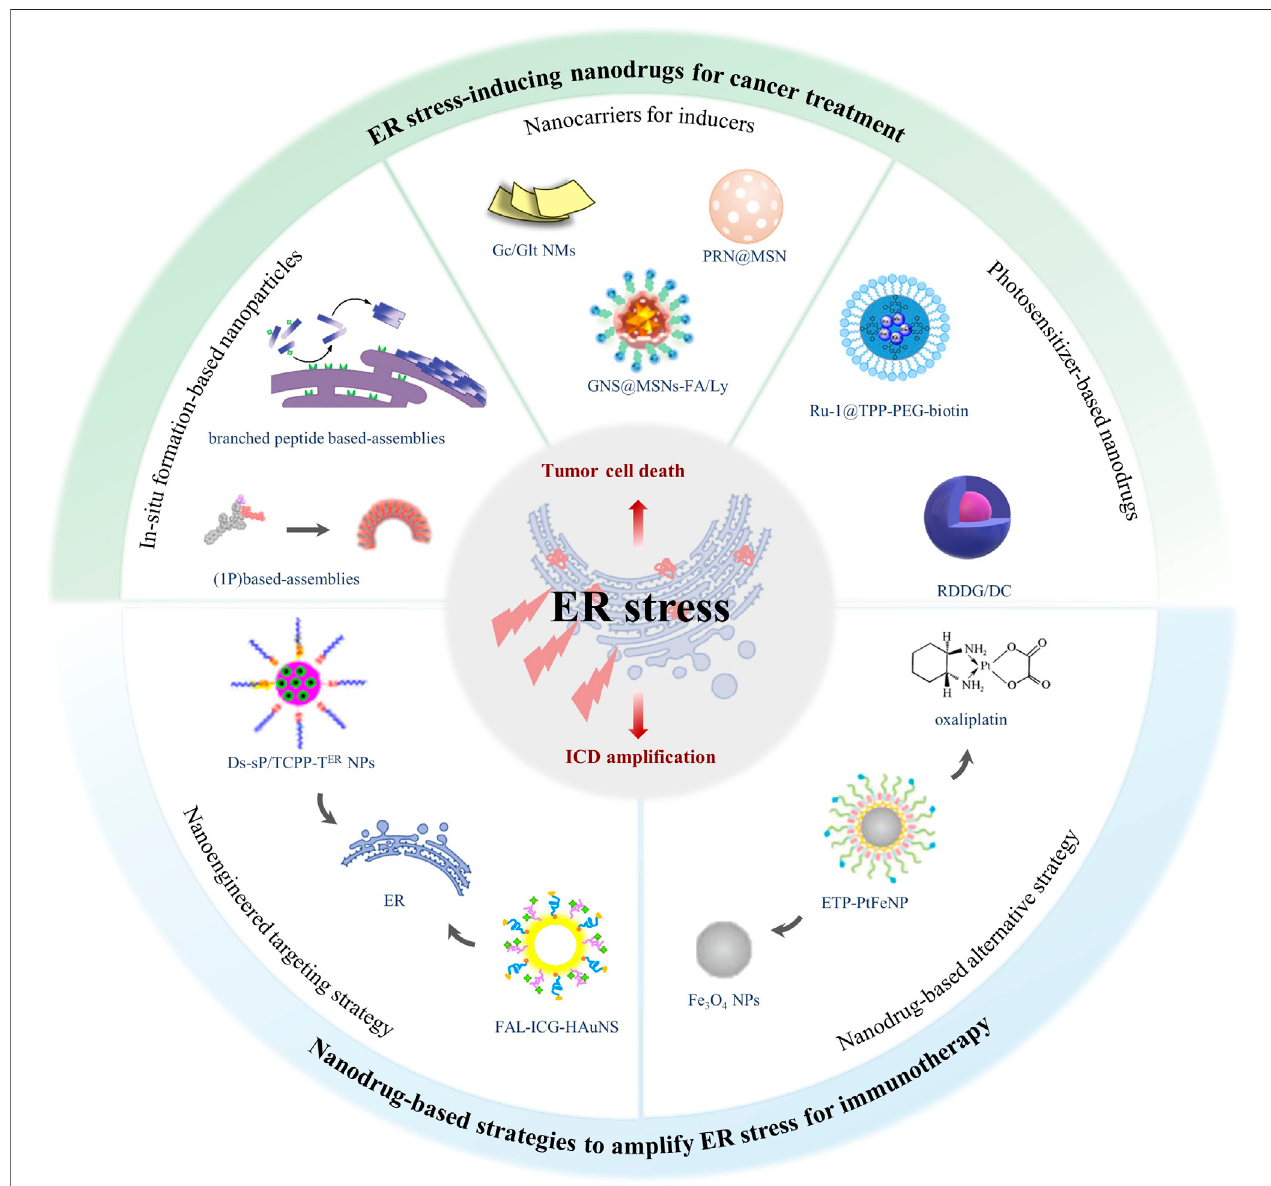
FIGURE 1 | The scope and focus of this article. Accumulation of misfolded protein results in ER stress, which can induce antitumor effects by triggering tumor cell death and amplifying ICD. ER stress – inducing nanodrugs can treat cancer through activating unsolved ER stress. In addition, nanodrugs amplifying ER stress via ER- targeting strategy and combination strategy make it possible for traditional ICD inducers to initiate antitumor immunotherapy.